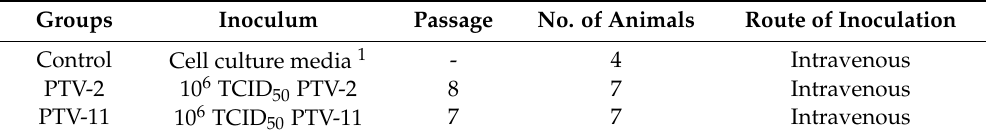
Table 1. Experimental design.